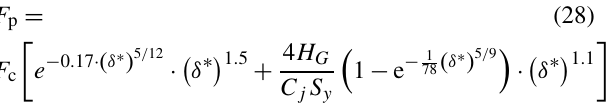
Figure 4. Schematic of the contact deflection during impact events.